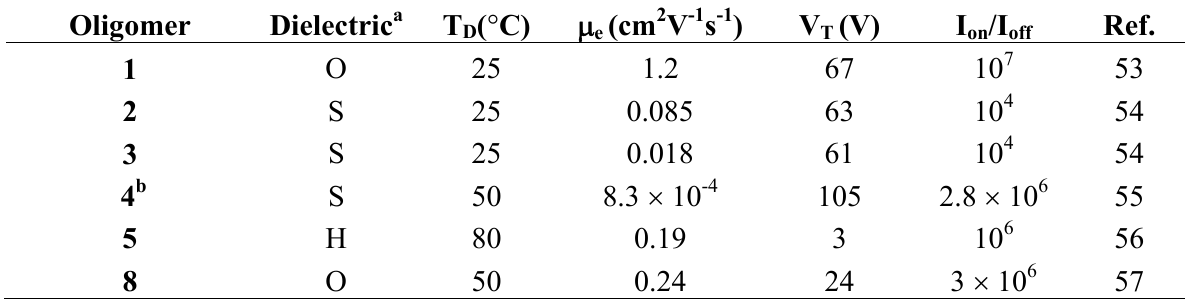
Table 2. Summary of the electrical performance (mobility, μ , current on/off ratio, I and threshold voltage, V ) of n-channel azine- and azole-derived oligomers. Top-contact T device architectures are utilized unless otherwise specified.